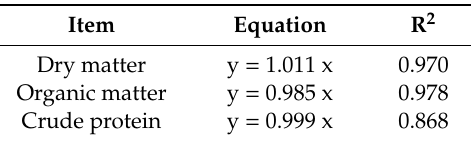
Table 4. Relationship between apparent digestibility (AD, %) of dry matter, organic matter and crude protein determined by stripping (y) and siphoning